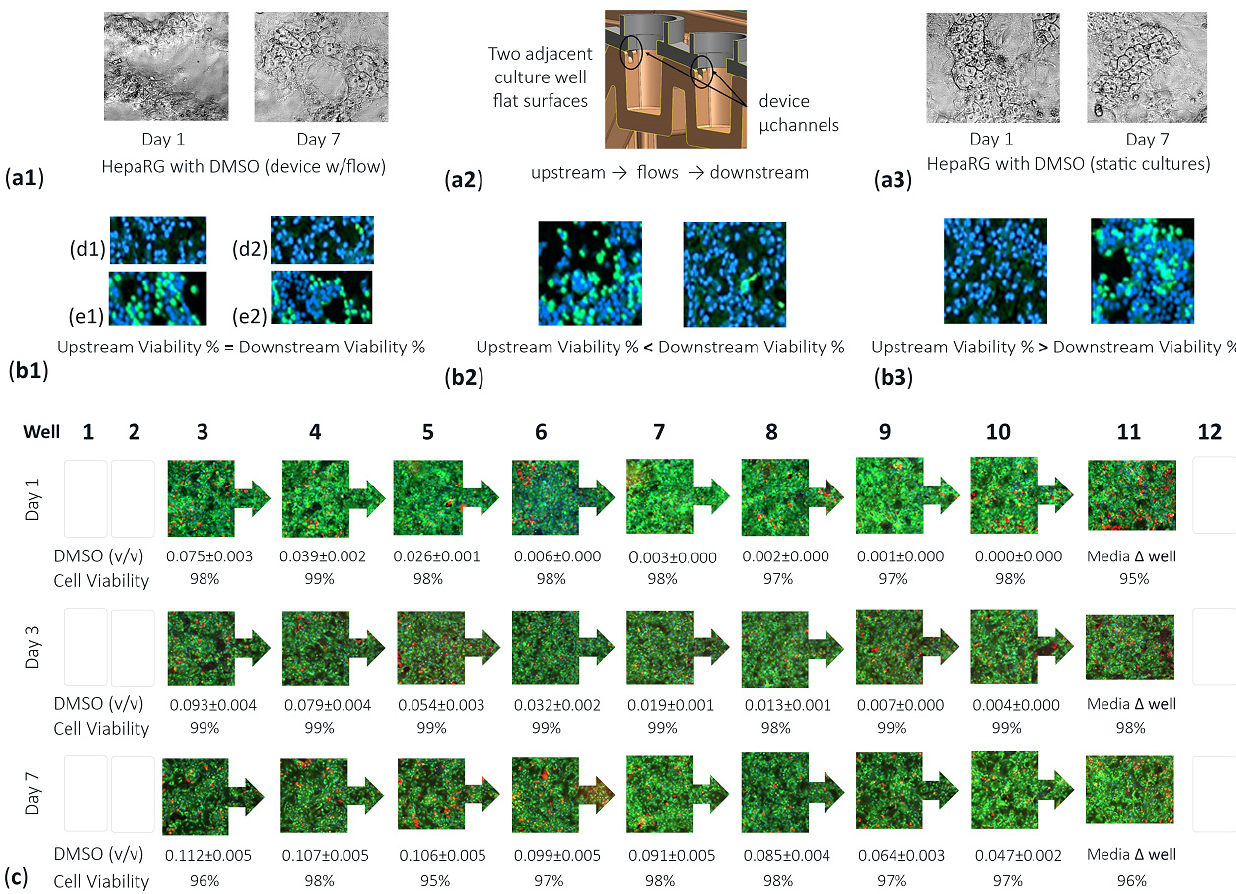
Figure 6. Morphology and viability of HepaRG cells in device multiwell culture locations, post 0.1% DMSO vehicle compound treatment. ( a2 ) Profile of device displaying two adjacent wells, two flat culture surfaces, and µchannels entering wells. ( a1 ) Kinetic (fluid flow) cultures with cell images at days 1 and 7, phase contrast brightfield 10×. ( a3 ) Comparative cell images at days 1 and 7 in static (no-flow) cultures, 10×. ( b1 – b3 ) Fluorescent image captures of cell nuclei stains (DAPI; blue) and non-viable stains (CellTox Green; green) for adjacent device wells, 4× pictorials. ( b1 ) Equivalent high cell viability ( d1 , d2 ), or equivalent lower cell viability ( e1 , e2 ). ( b2 ) Upstream device well displaying lower cell viability vs. downstream well. ( b3 ) Upstream device well displaying higher cell viability vs. downstream well. ( c ) Fluorescent image captures of cell nuclei stains (DAPI; blue), viable cells (Calcein AM; green), and non-viable cells (Ethidium Homodimer; red) to assess variance of cell viability across device wells 3–11. (Day 1) Auto-DMSO concentration gradients after a single 0.1% DMSO bolus dose (0.1 v/v ) into well 1. (Day 3) After three 0.1% DMSO re-doses into well 1; daily re-dosing. (Day 7) After seven 0.1% DMSO re-doses into well 1. Overall, cell viability remains effectively unchanged,